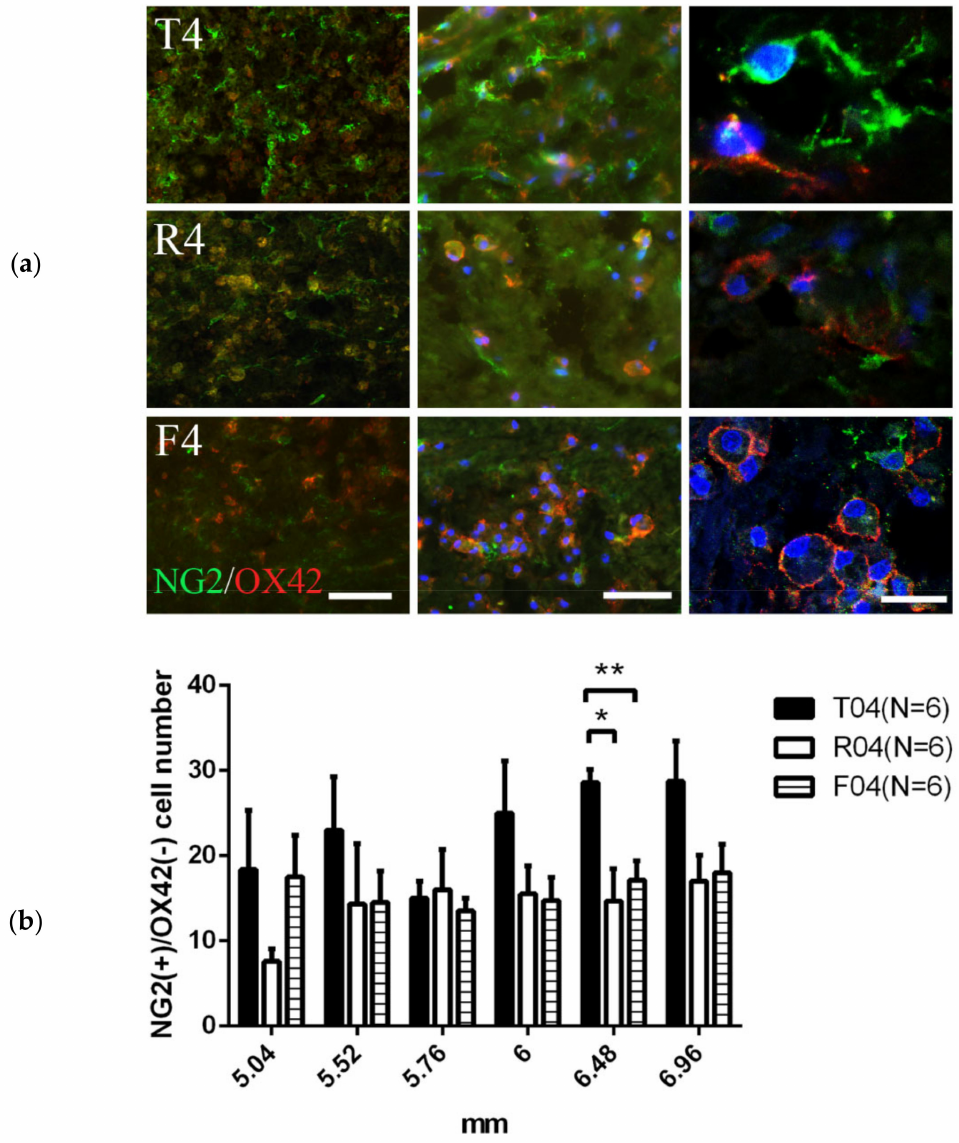
Figure 4. A cross-section showing the cells around the center cavity in the dorsal column of a caudal stump. ( a ) At 4 days post-operation, a degenerative cavity began to form in the center of the dorsal funiculus in the T4 group. NG2(+) Ox42( − ) OPC were present near in the cavity site in T4 and to a lesser extent in F4 and R4. Animal number used: T4 ( n = 6), R4 ( n = 6), F4 ( n = 6). ( b ) The numbers of NG2(+) Ox42 ( − ) OPCs were significantly different in some specific location around 6 mm from trauma center between T4 and R4, as well as between T4 and F4. Statistical significance was evaluated using one-way ANOVA and Tukey’s test. *: p < 0.05. **: p < 0.01. Data are presented as mean ± SEM. Animal number used: T4 ( n = 6), R4 ( n = 6), F4 ( n = 6). Left scale bar= 100 µ m, middle scale bar = 50 µ m, right scale bar = 10 µ